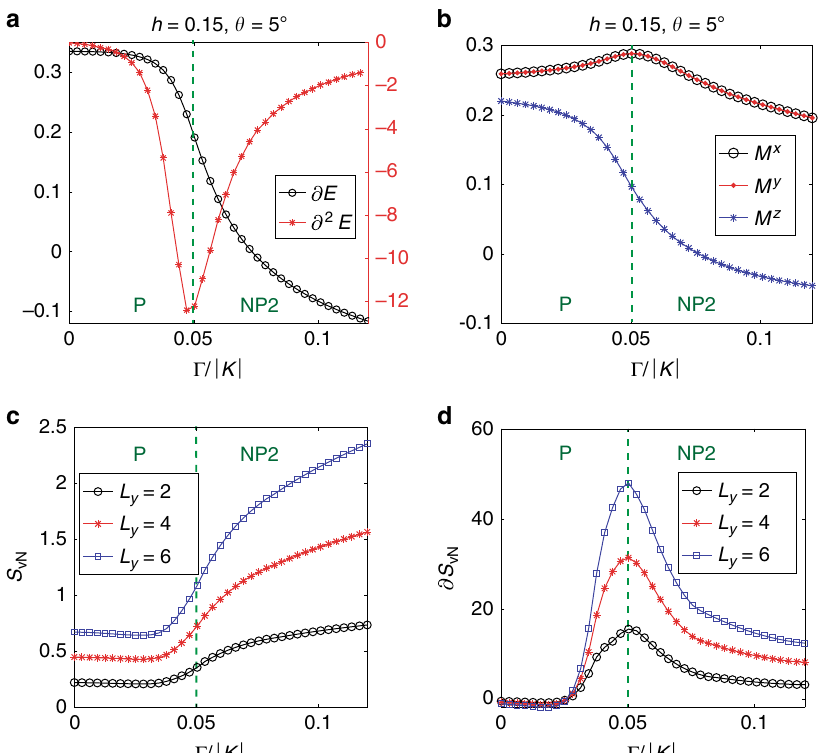
Fig. 3 Transition between the P and NP2 phases. Plots of a the fi rst and second derivatives of the energy density, b magnetization components, ), and d its fi rst derivative with the tilting angle θ ¼ 5 (cid:5) and h ¼ 0 : 15. Here S c entanglement entropy ( S vN circumference L y . The information on numerical parameters is given in the “ Methods ”